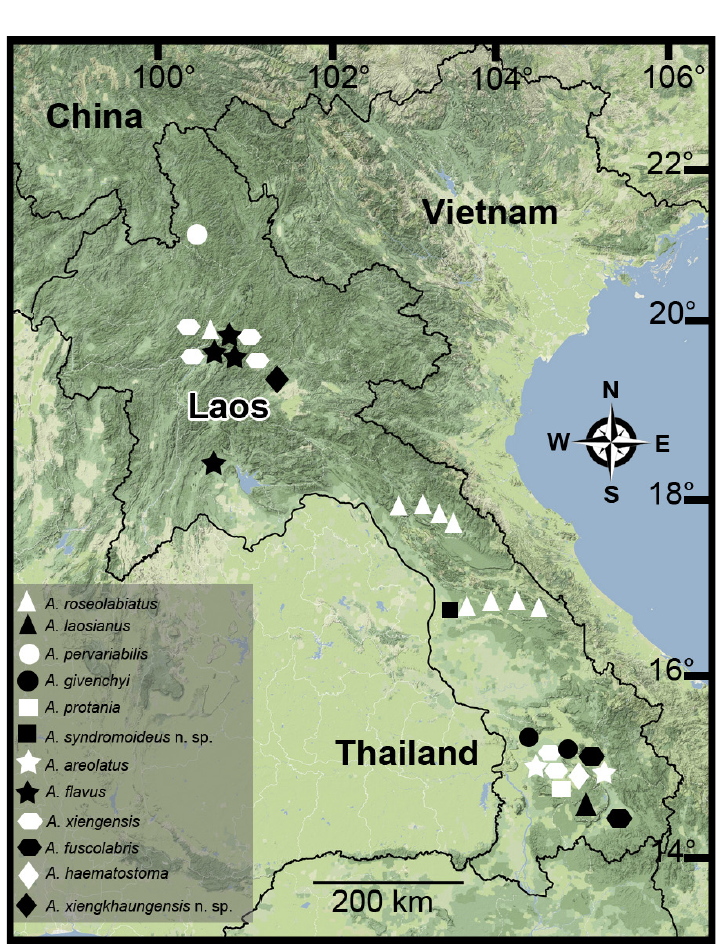
Fig. 1. Distribution map of Amphidromus spp. in Laos recognized in this